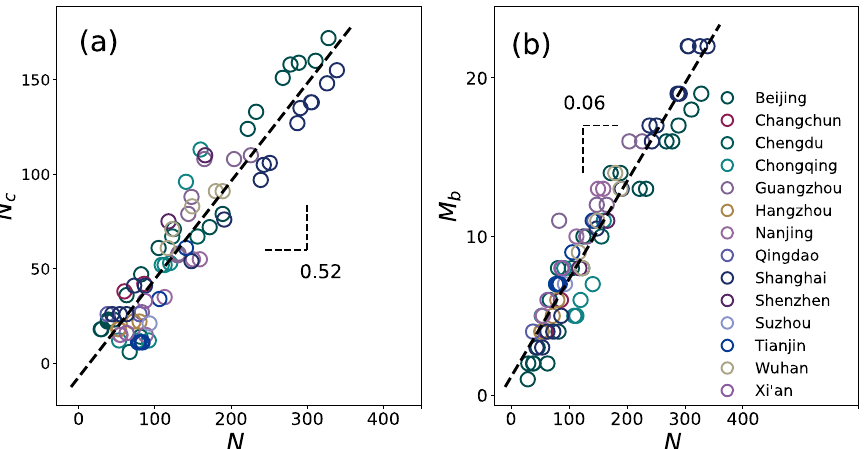
Figure 3. ( a ) Number of nodes in the core ( N c ) versus network size ( N ) . A linear fit (dashed line) gives N c = 0.52 N − 7.41 ( R 2 = 0.90 ) , or in other words, a minimum core (e.g., a triangle form) comprises at least 20 nodes. ( b ) The number of branches ( M b ) versus N for metro networks in this article. M b ∼ 0.06 N ( R N c , M b and N are aggregated by various cities over the